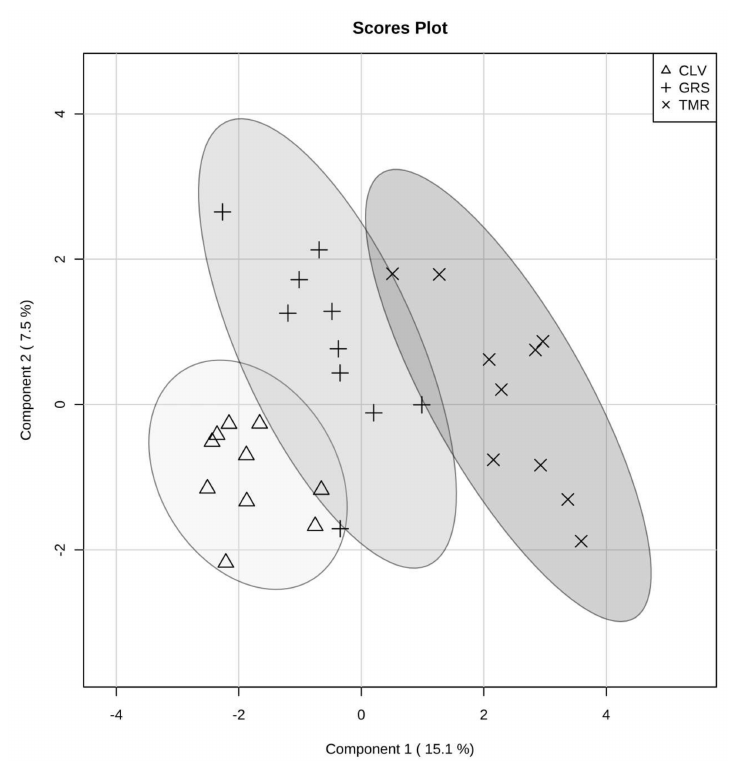
Figure 6. Partial least square discriminant analysis (PLS-DA) score plot of mid-lactation raw milk metabolome of cows fed diets consisting of total mixed ration (TMR), perennial ryegrass (GRS), or perennial ryegrass and white clover (CLV), as determined by 1 H-NMR. The shaded ellipses represent the 95% confidence interval estimated from the